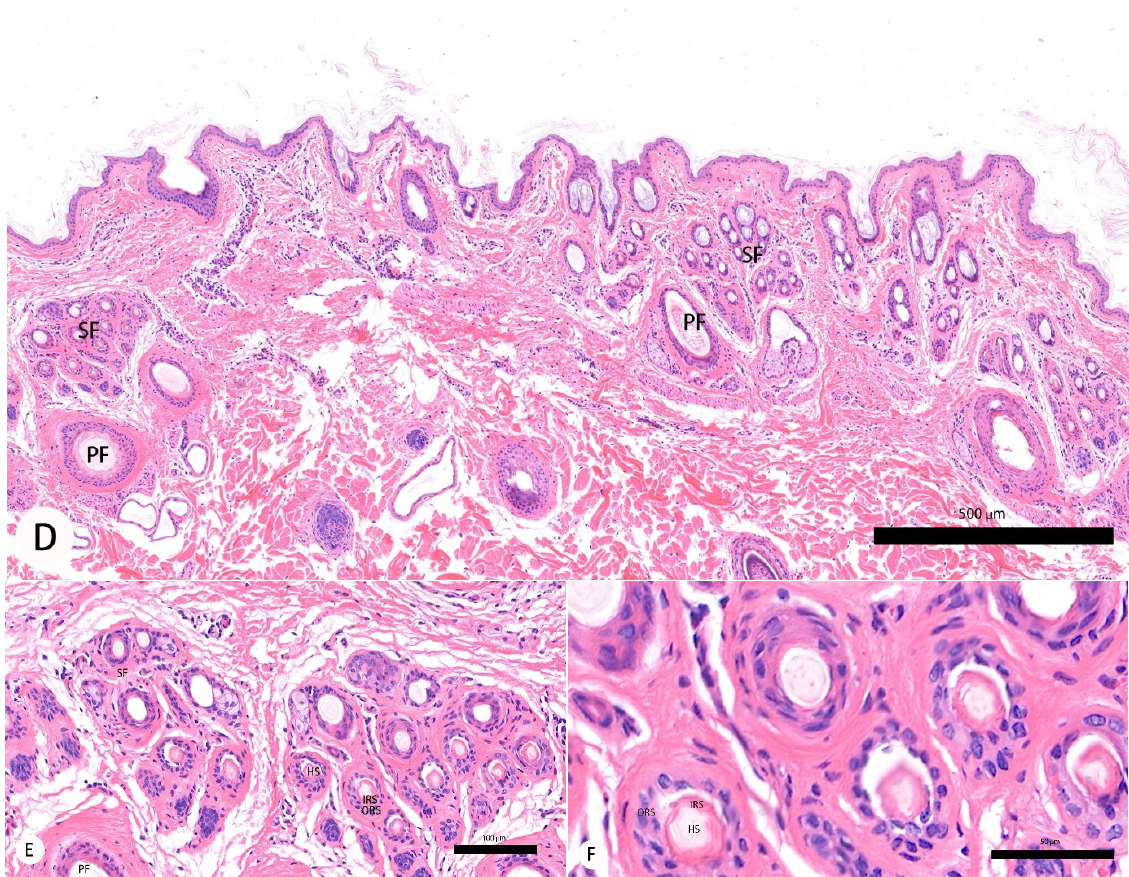
Figure 1. Photomicrographs of secondary hair follicles of cashmere goats. ( A ) Section of skin from a goat from Rikaze. Arrows indicate the epidermis while arrowheads indicate finger cell groups. ( B , C ) Secondary hair follicles of a goat from Rikaze. The secondary hair follicles are in the proanagen stage. ( D ) Section of skin from a goat from Huan. The arrows indicate the epidermis. ( E , F ) Secondary hair follicles of a goat from Huan County. The secondary hair follicles are in the anagen phase. PF: primary hair follicle; SF: secondary hair follicle; HS: hair shaft; IRS: inner root sheath; ORS: outer root sheath. ( A , D ) 100×; ( B , E ) 200×; ( C , F ) 400×.